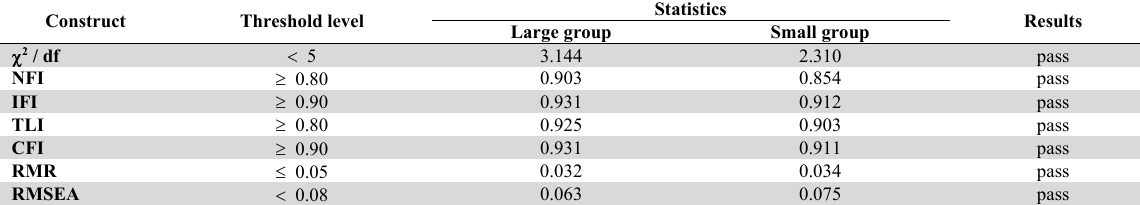
The goodness-of-fit indices of the structural equation model to the recommended threshold values Construct